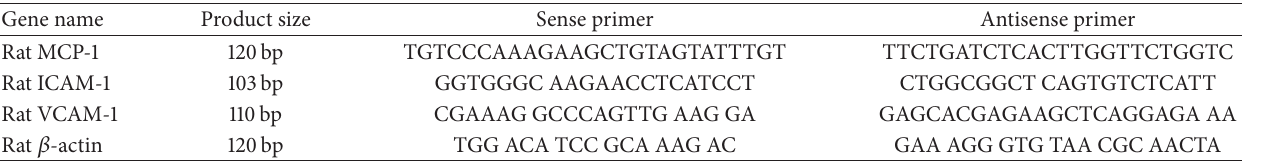
Table 1: Sequences of